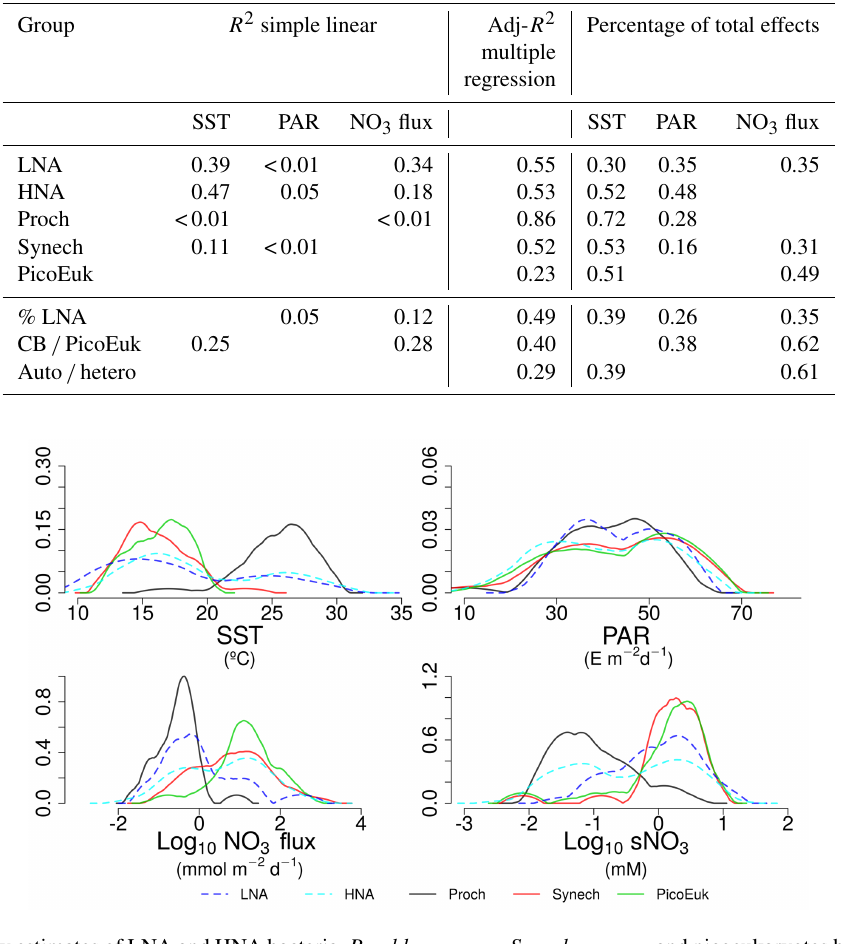
Figure 5. Kernel density estimates of LNA and HNA bacteria, Prochlorococcus , Synechococcus , and picoeukaryotes based on the considered niche descriptors: sea surface temperature (SST), surface photosynthetically active radiation (PAR), nitrate flux (NO 3 flux), and surface concentration (sNO 3